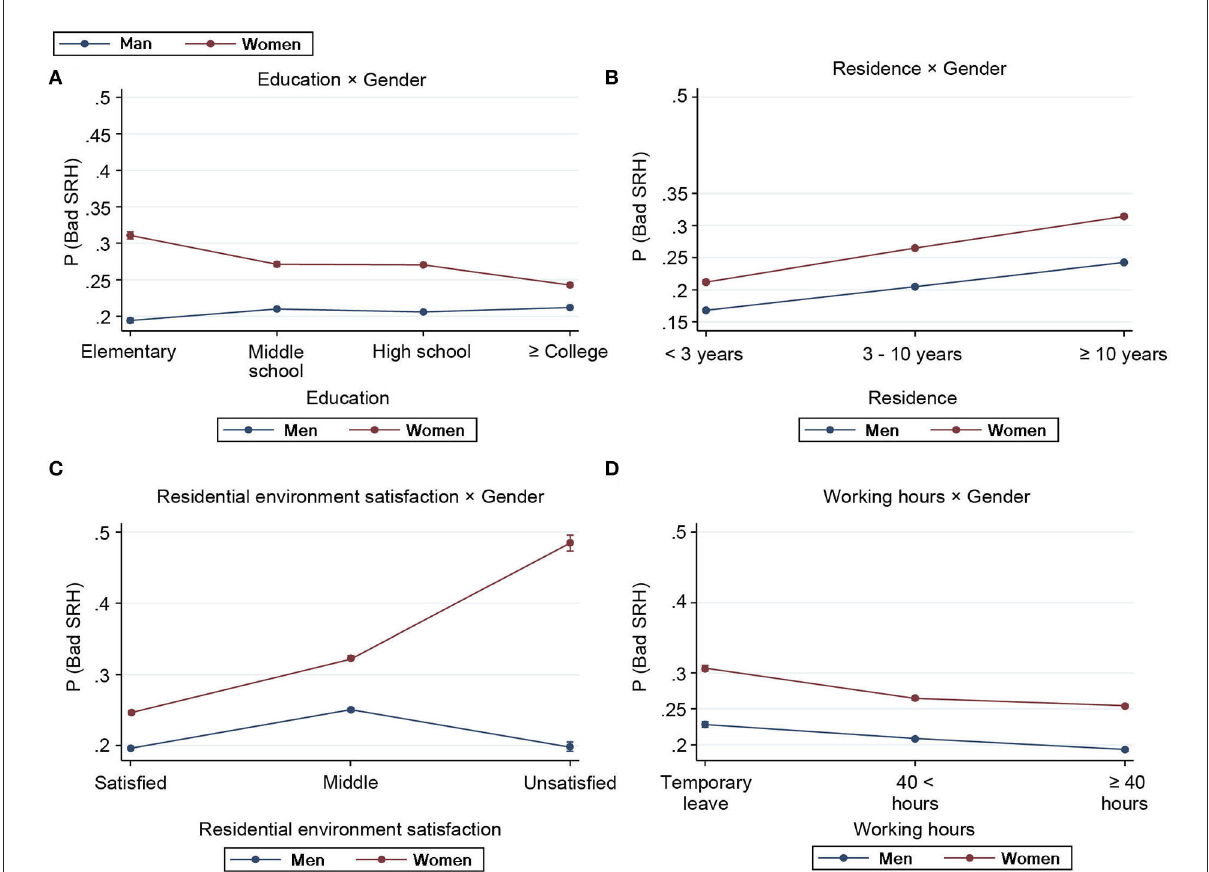
FIGURE2 Estimated scores and marginal effects of the interaction effects of gender with the variables of education (A) , length of residence (B) , residential environment satisfaction (C) , and working hours (D)